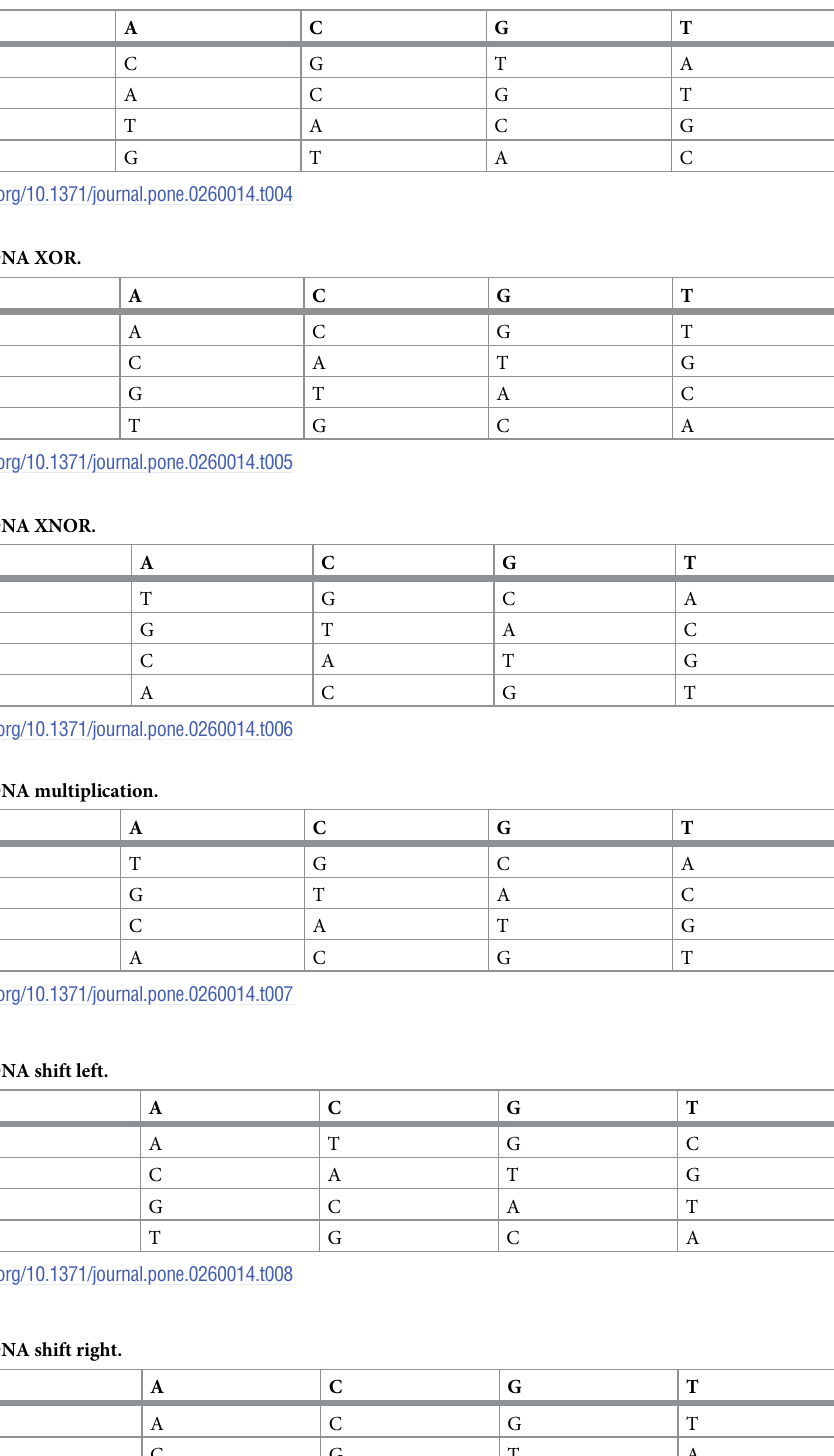
Table 4. DNA subtraction.